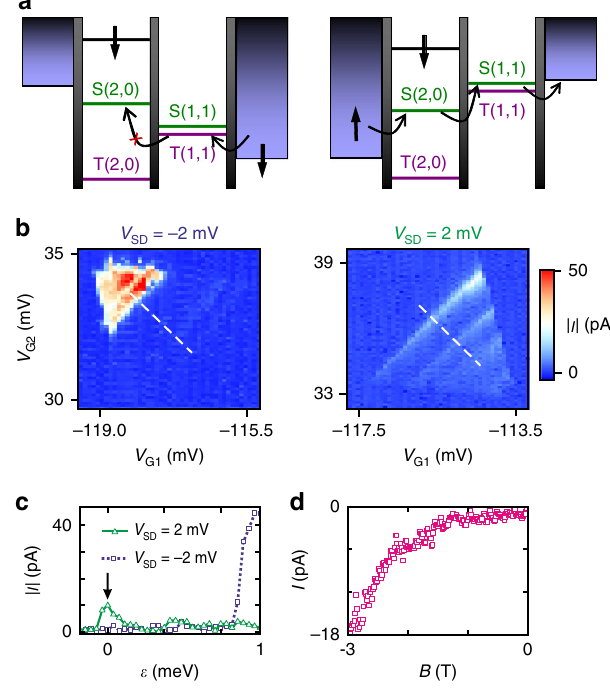
Fig. 2 Spin blockade in DQDs. a Schematic presentation of PSB for a hole DQD. Transport is blocked for the transition (1, 1) → (2, 0) (left panel) due to the Pauli exclusion principle and can be lifted by reversing the applied bias voltage (right panel). b Bias triangles exhibiting PSB at negative bias voltages (left). Reversing the bias results in an enhancement of the baseline current (right). c Comparison of the current from two line cuts along the detuning axis for positive (green triangles, solid line) and negative (blue squares, dotted line) bias voltages. The positions where the line cuts were taken are indicated by white dashed lines in b . d Dependence of the leakage current at zero detuning for an out-of-plane magnetic fi eld and for a bias voltage of − 2